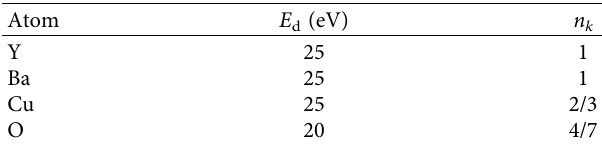
Table 2: The values of E d and n k for YBa 2 Cu 3 O 7 .